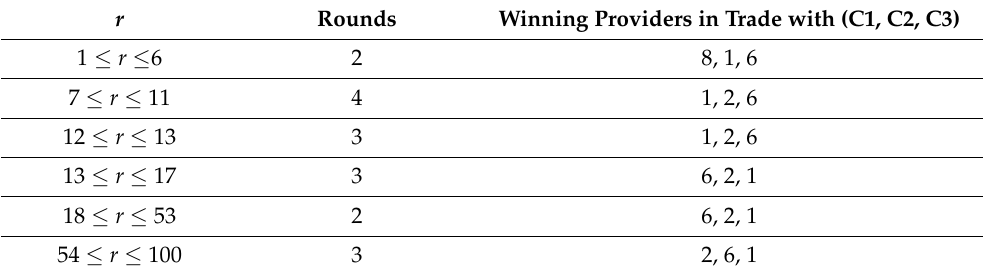
Table 3. Required rounds and winning providers using the proposed strategy calculated with different reliability coefficients.